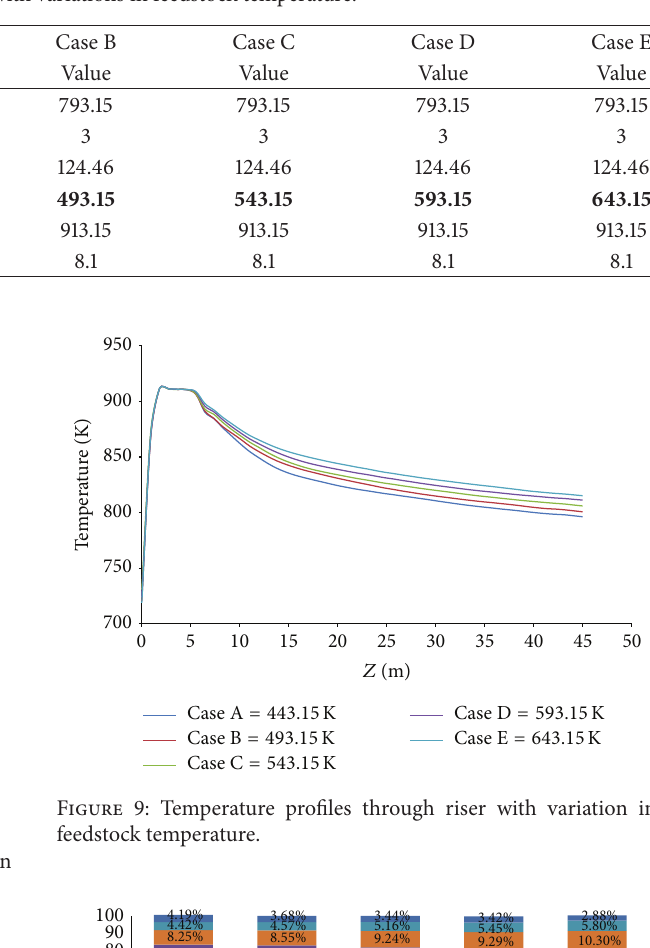
Table 6: Operating conditions with variations in feedstock temperature.